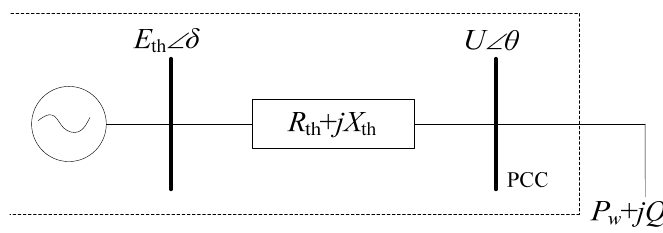
Figure 5. Initial voltage security region Ω